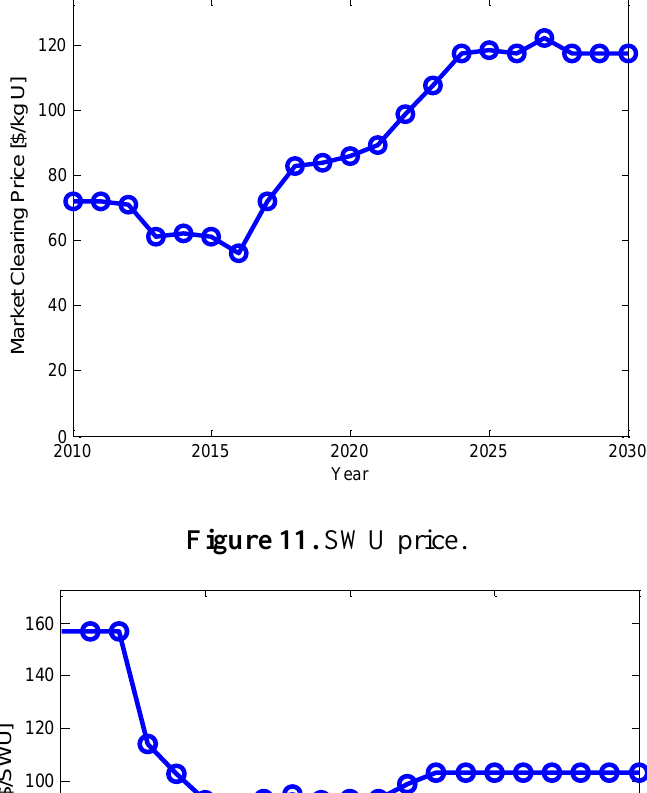
Figure 10. Market clearing uranium price.